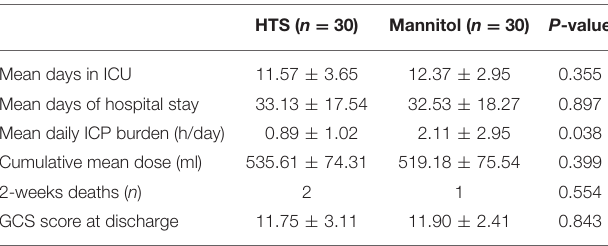
TABLE 2 | Study outcomes in the two groups.